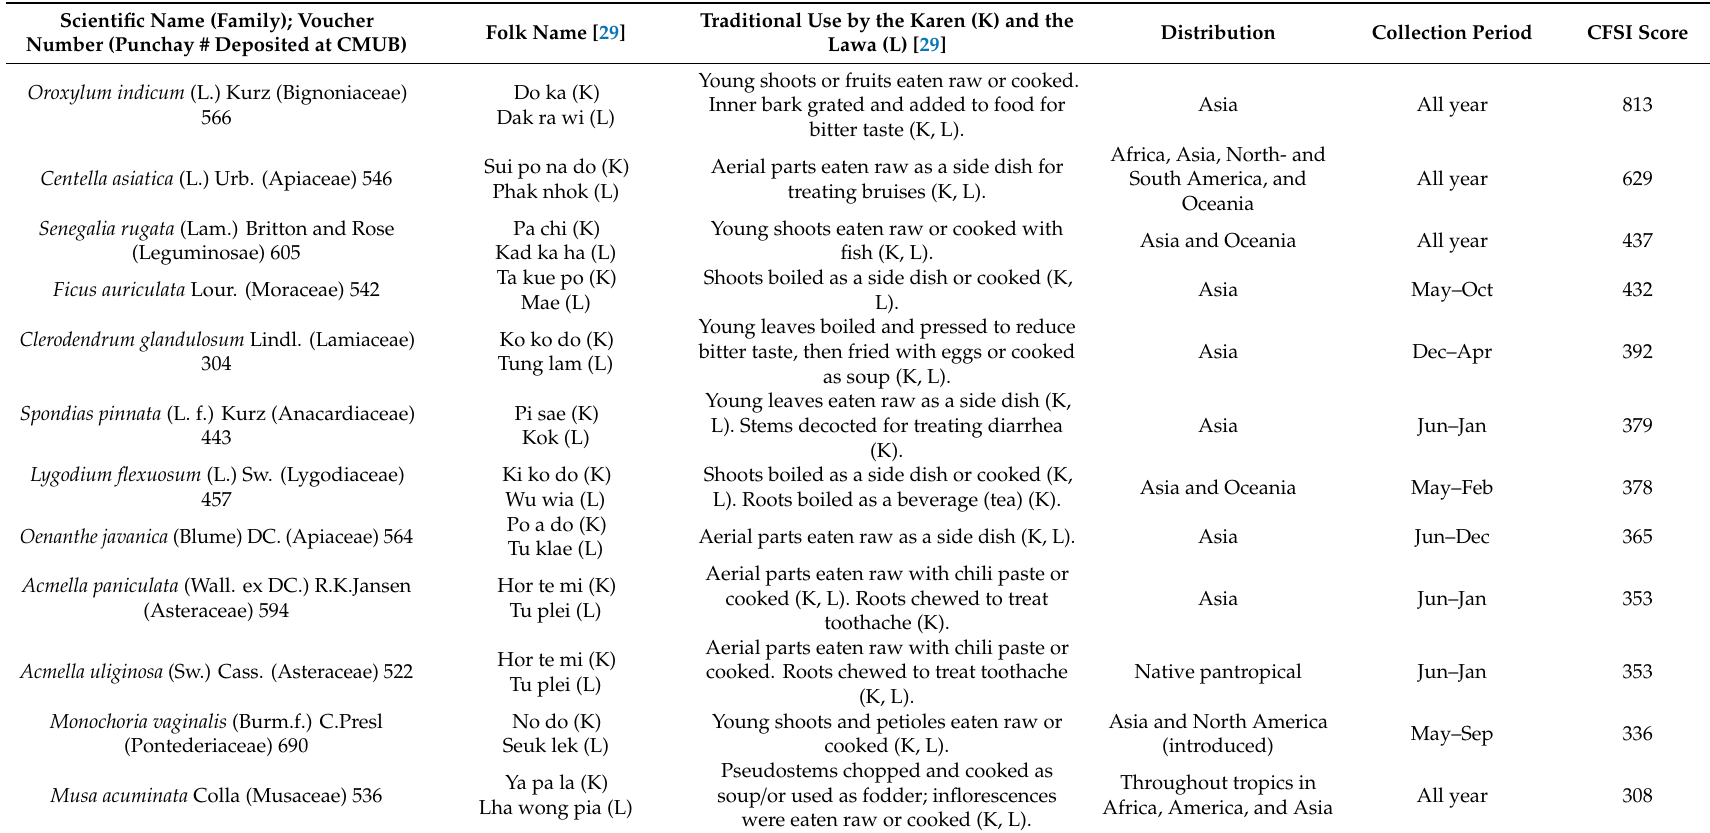
Table 1. Twelve wild leafy vegetable species encountered in two Karen and two Lawa villages in northern Thailand, giving their scientific name, family, common name in English, ethnobotanical information, distribution, collection period, and their Cultural Food Significance Index (CFSI)